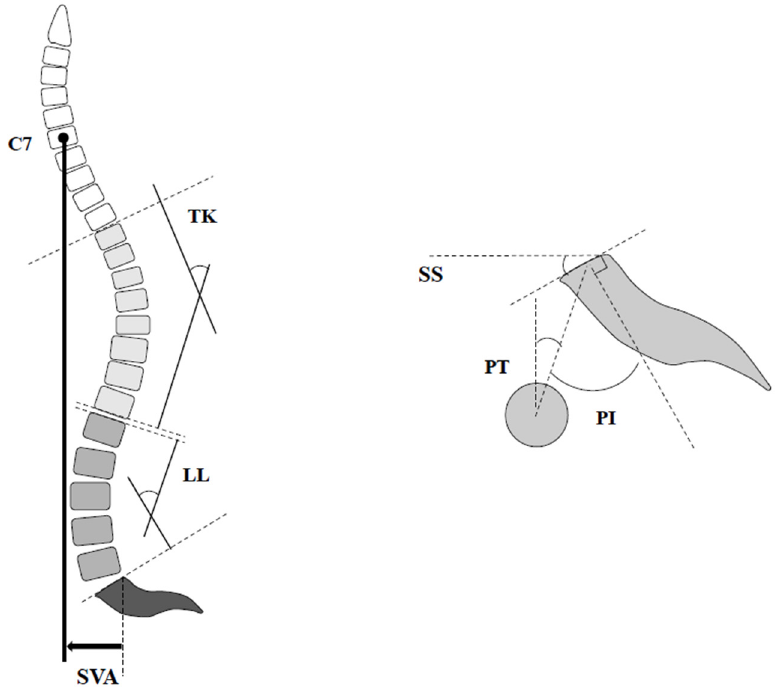
Figure 1. Illustration of various spinopelvic parameters. LL: lumbar lordosis; TK: thoracic kyphosis; PI: pelvic incidence; PT: pelvic tilt; SS: sacral slope; SVA: sagittal vertical axis.